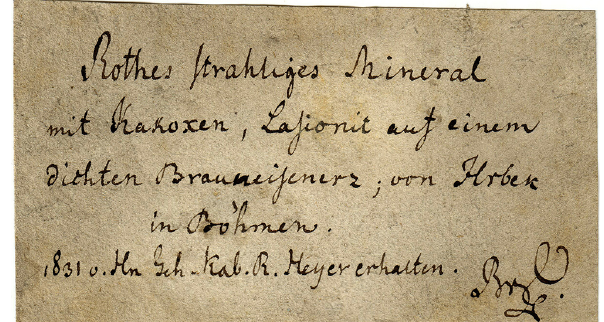
Figure 2. Original label of the original beraunite specimen written by Friedrich August Breithaupt in 1831. “Rothes strahliges Mineral mit Kakoxen, Lasionit auf einem dichten Brauneisenerz; von Hrbek in Böhmen. 1831 v. [von] Hn [Herrn] Geh. Kab. R. [Geheimen Kabinettsrath] Heyer erhalten. Br [Breithaupt].”